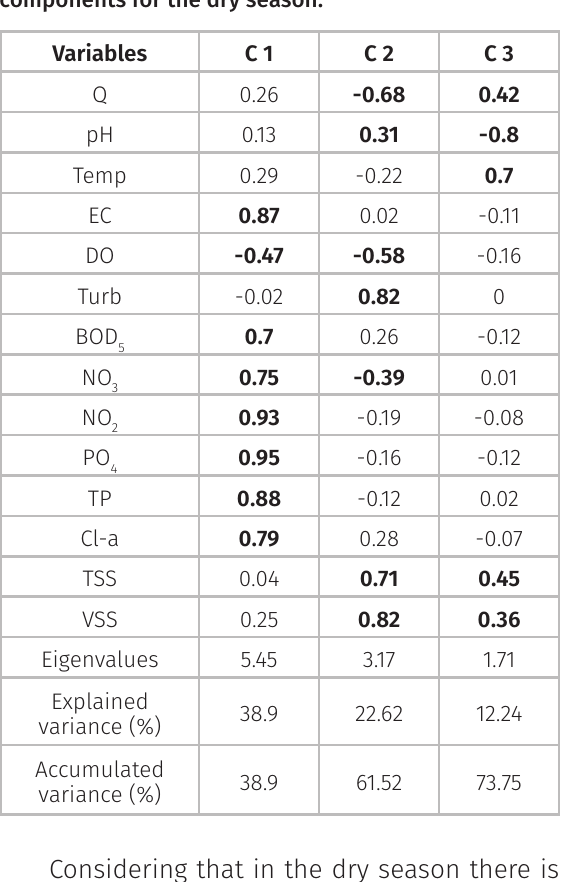
Table IV. Factor loading of variables and principal components for the dry